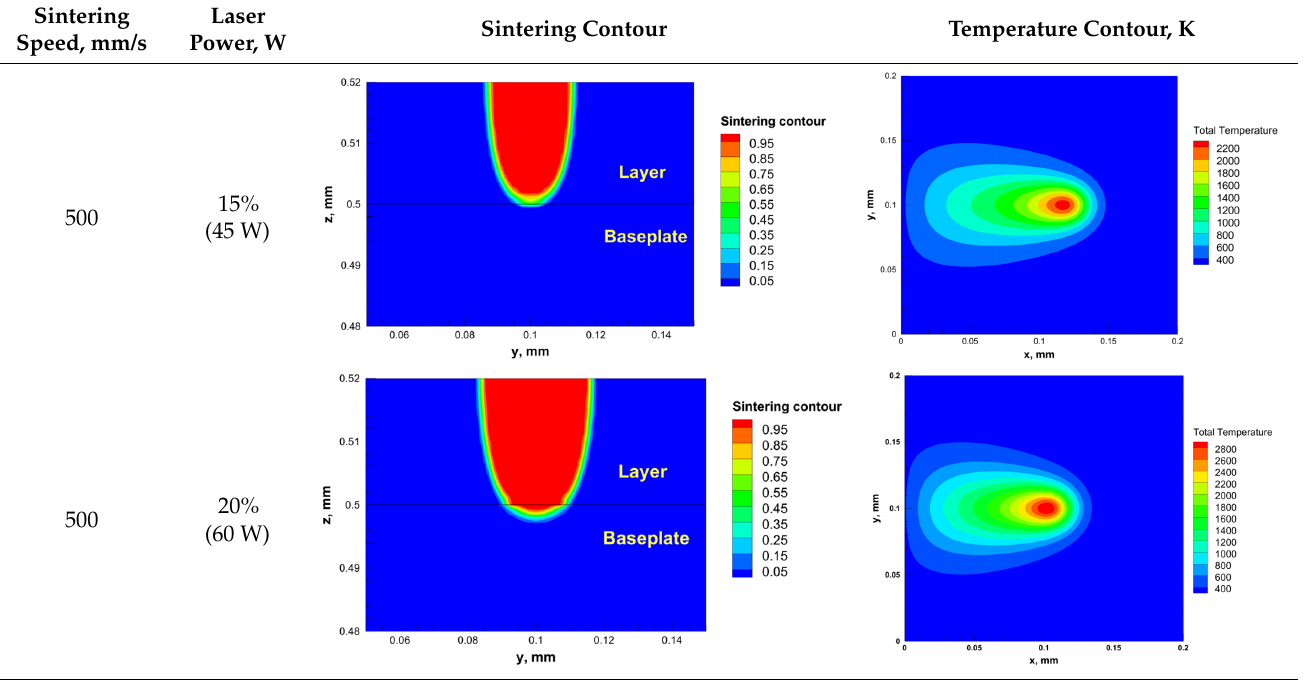
Table 4. Laser power selection for sintering speeds of 250 and 100 mm/s.